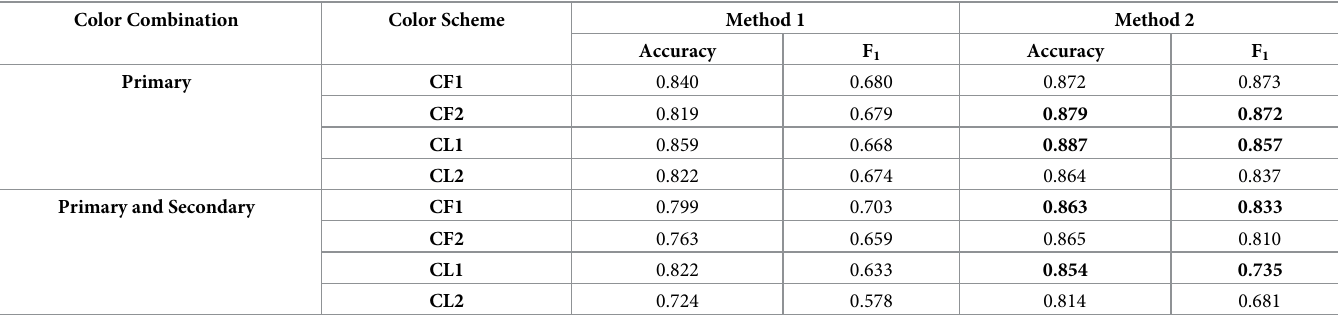
Table 5. Accuracy and F 1 for the combined binary classifiers.